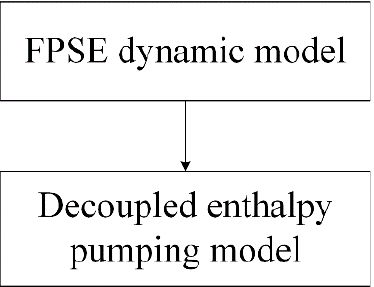
Figure 6. Flowchart of the decoupled enthalpy pumping model.